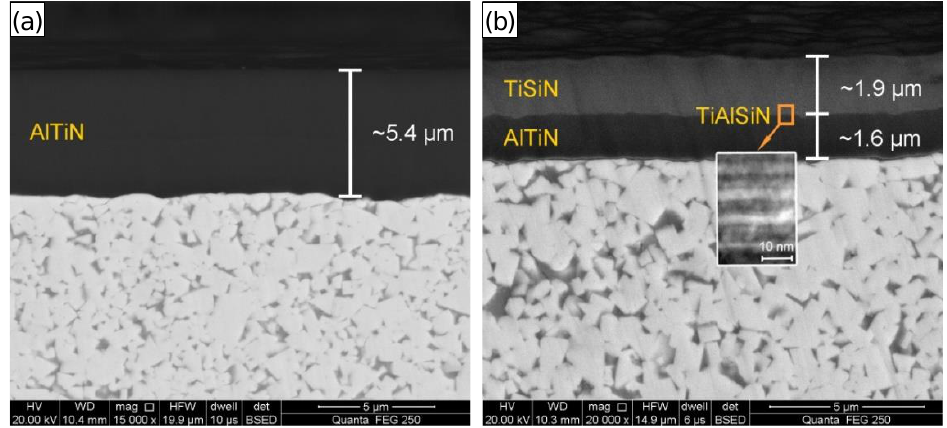
Figure 2. Cross-sectional SEM micrographs of AlTiN-based films (submicron 10Co substrates): ( a ) AlTiN single-layer film; ( b ) TiSiN/TiAlSiN/AlTiN multilayer film.